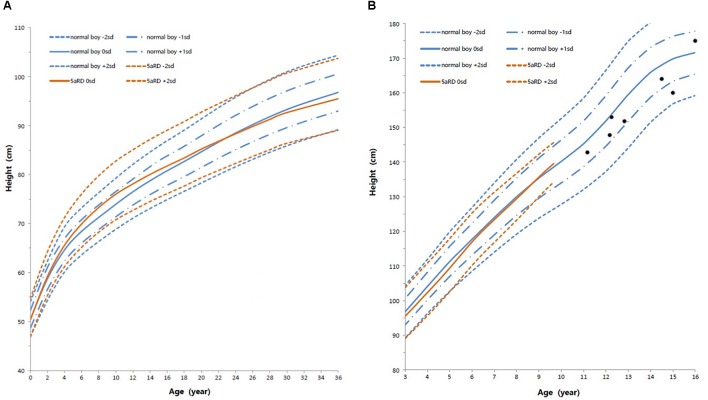
Standard deviation height curves between children with 5aRD and normal Chinese boys (0–16 years old). (A) Aged 0–36 months old; (B) Aged 3–16 years old. Red is 5αRD; Blue is the normal Chinese boy. Black spot is the patients of 5αRD older than 13 years. sd, standard deviation scores.